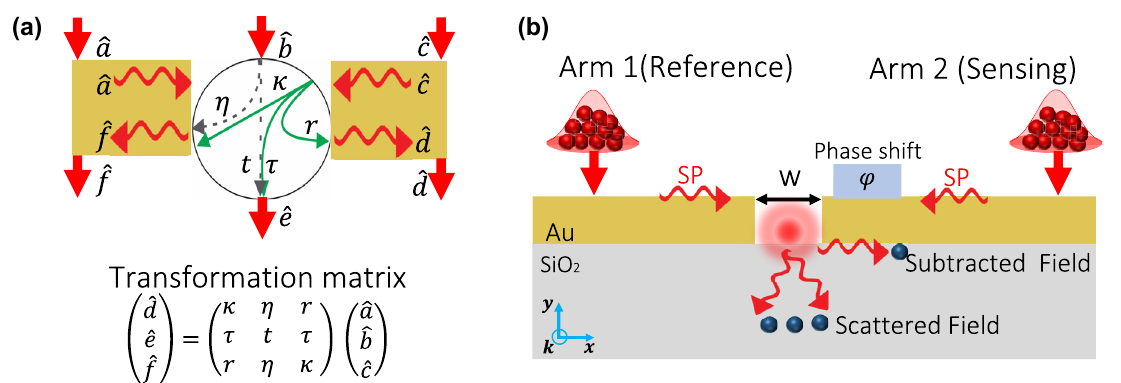
Figure 1: Optical interactions in the plasmonic nanoslit and its use for conditional quantum sensing. (a) Schematic diagram of the interactions in a plasmonic nanoslit. The plasmonic nanostructure has three input and three output ports. The ̂ photonic mode at the input is described by the operator b , whereas the two plasmonic modes are represented by ̂ a and ̂ c . These modes are ̂ ̂ coupled to the plasmonic modes d and f , and to the photonic mode ̂ e at the output of the nanostructure. As described by the transformation matrix, the parameters 𝜅 , 𝜏 , r , 𝜂 , and t represent the coupling coefficients among the ports of the nanostructure. For sake of clarity, the ̂ diagram only illustrates the coupling paths for the input modes b and ̂ c . The diagram in (b) shows the design of our simulated plasmonic sensor, comprising a slit of width w in a 200 nm gold thin film. Here, the plasmonic structure is illuminated by two thermal multiphoton sources that excite two plasmonic fields with super-Poissonian statistics (the input grating couplers are not shown in the figure). The two substrate. The interference counter-propagating surface plasmon (SP) modes interfere at the interface between the gold layer and the SiO 2 conditions are defined by the phase shift 𝜑 induced in one of the plasmonic modes by the substance that we aim to